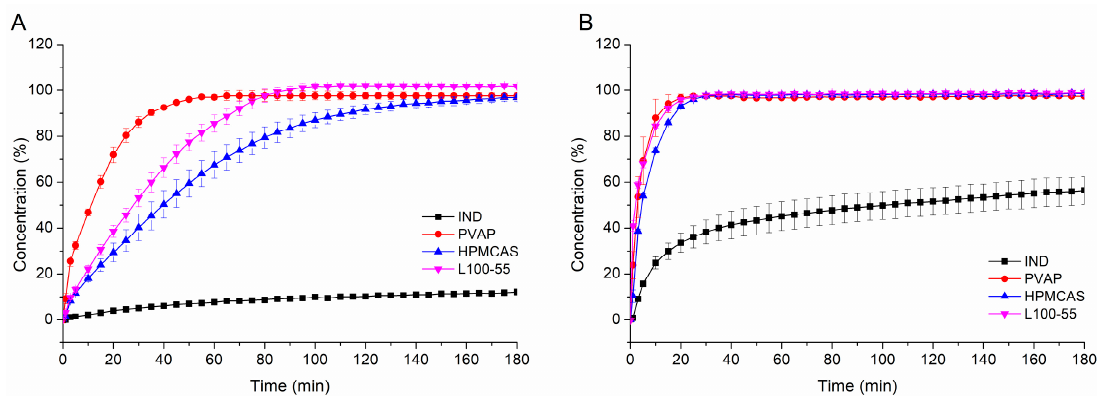
Figure 9. Non-sink dissolution of the IND-PVAP, - hydroxypropylmethylcellulose acetate succinate (HPMCAS), -L100-55 ASDs at pH 5.5 ( A ) and pH 6.8 ( B ).